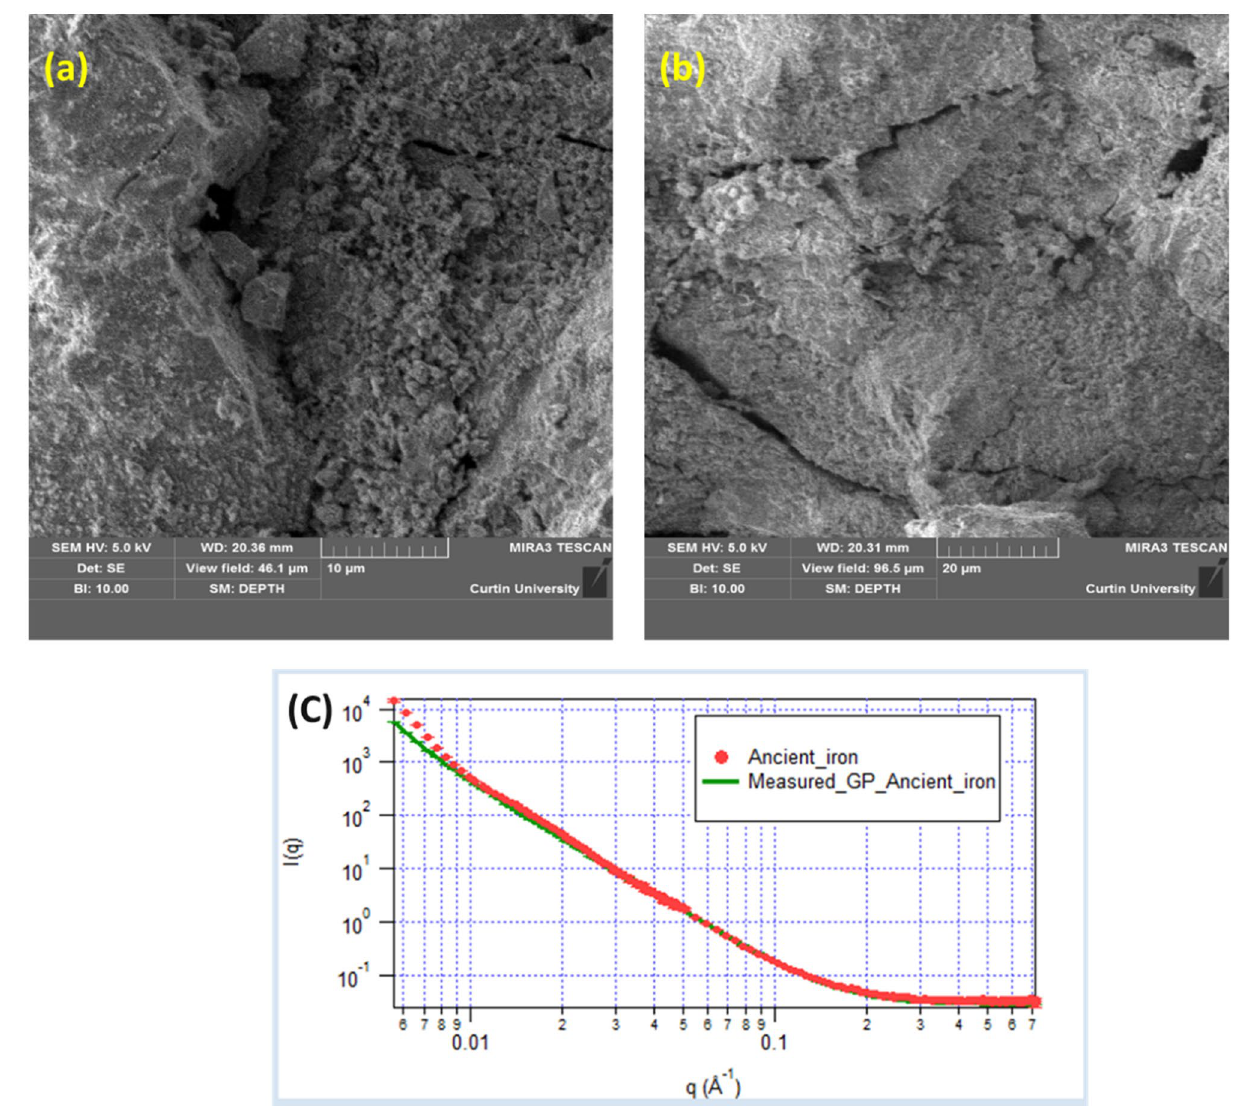
Figure 2. ( a ) FESEM image of the corrosion product film found on the top of the iron made by Agaria tribe ( b ) FESEM image depicting the inhomogeneity in the shape and size of the corrosion phase particles that are found in corrosion product film ( c ) represent the small-angle neutron scattering (SANS) scattering data collected from the iron made through ancient Indian metallurgical methods, scattering data is fitted with the Guinier-Porod